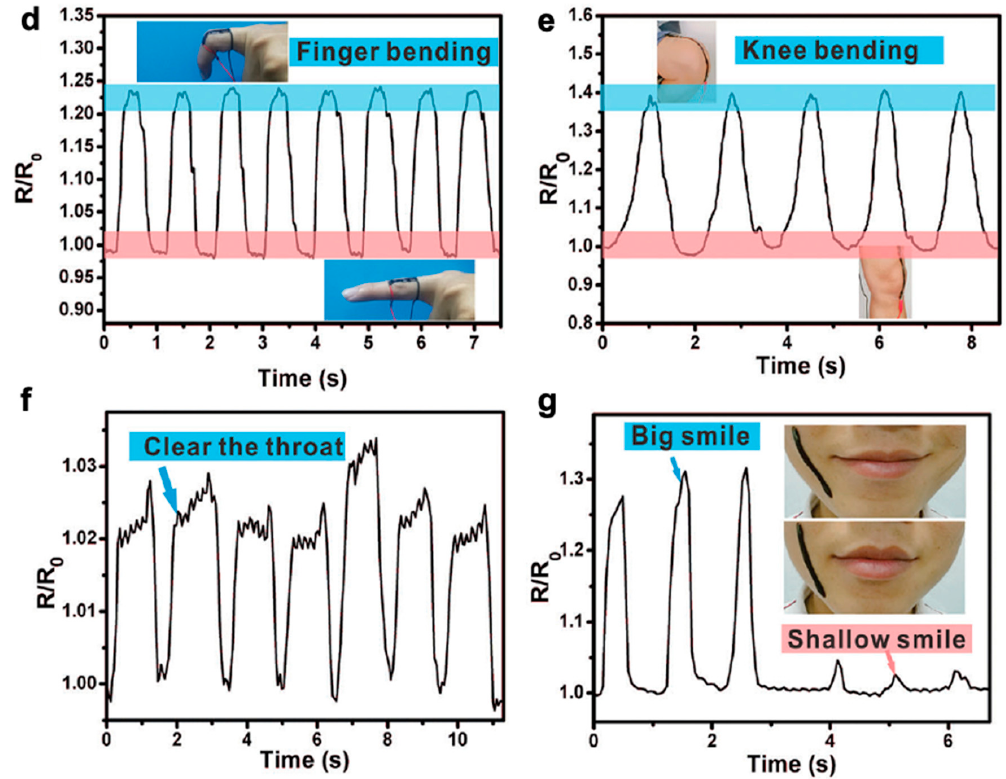
Figure 11. ( a – c ) Demonstration of PVA / PDA hydrogel compliance, fluidity, and self-adhesion to fingertip. Motion detection demonstration of the PVA / PDA hydrogel with ( d ) finger bending, ( e ) knee bending, ( f ) throat movement, and ( g ) smiling. Reprinted with permission from [230]. Copyright 2018 The Royal Society of Chemistry.